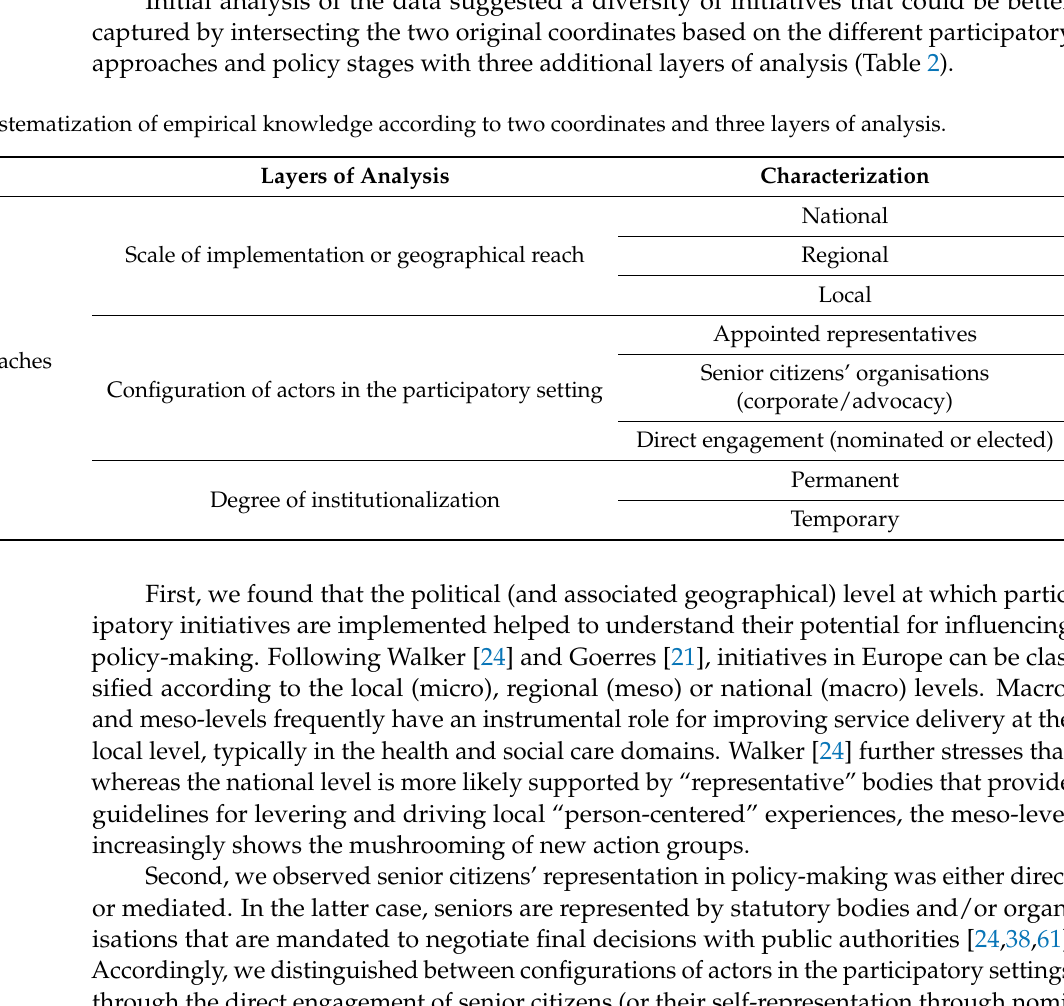
Table 2. Systematization of empirical knowledge according to two coordinates and three layers of analysis. Coordinates Layers of Analysis